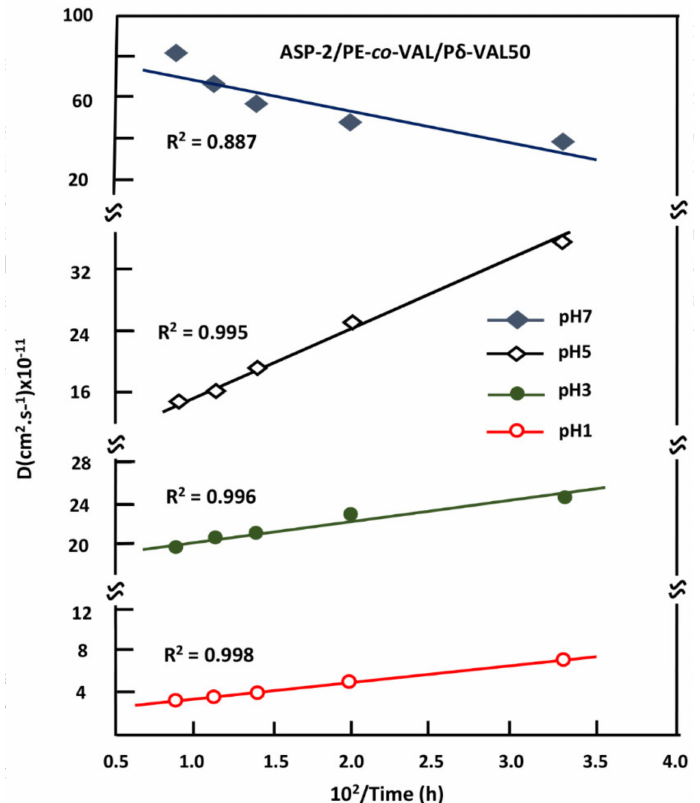
Figure 12. Variation of the diffusion coefficient of ASP through the PE- co -VAL/P δ -VL carrier versus the inverse of